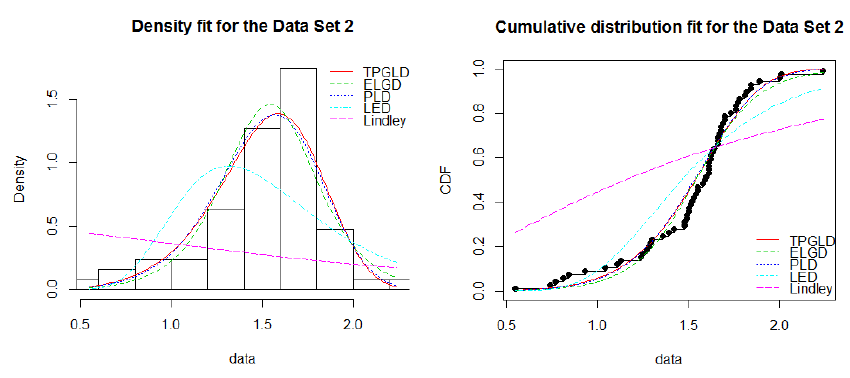
Figure 4 – Density and cumulative distribution fit for the strengths of glass fiber